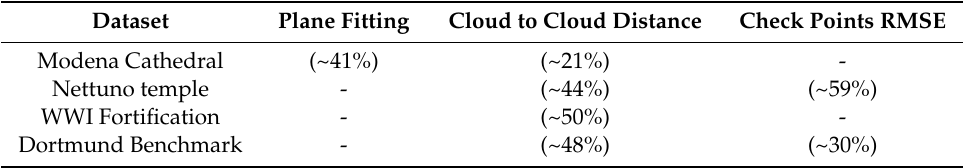
Table 19. Summary of average 3D reconstruction improvements in the considered four datasets verified with the available ground truth